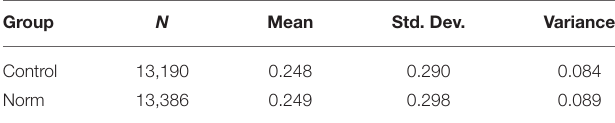
TABLE 2 | Summary statistics of hourly energy consumption of sample